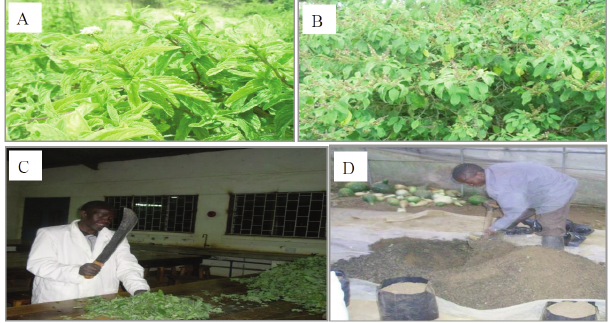
Fig. 1 ­ A. Lippia kituensis Vatke and B. Ocimum gratissimum L.; C. Chopping of the fresh Ocimum gratissimum plants into smaller pieces; D. Potting of the mixture (soil amend­ ment process).